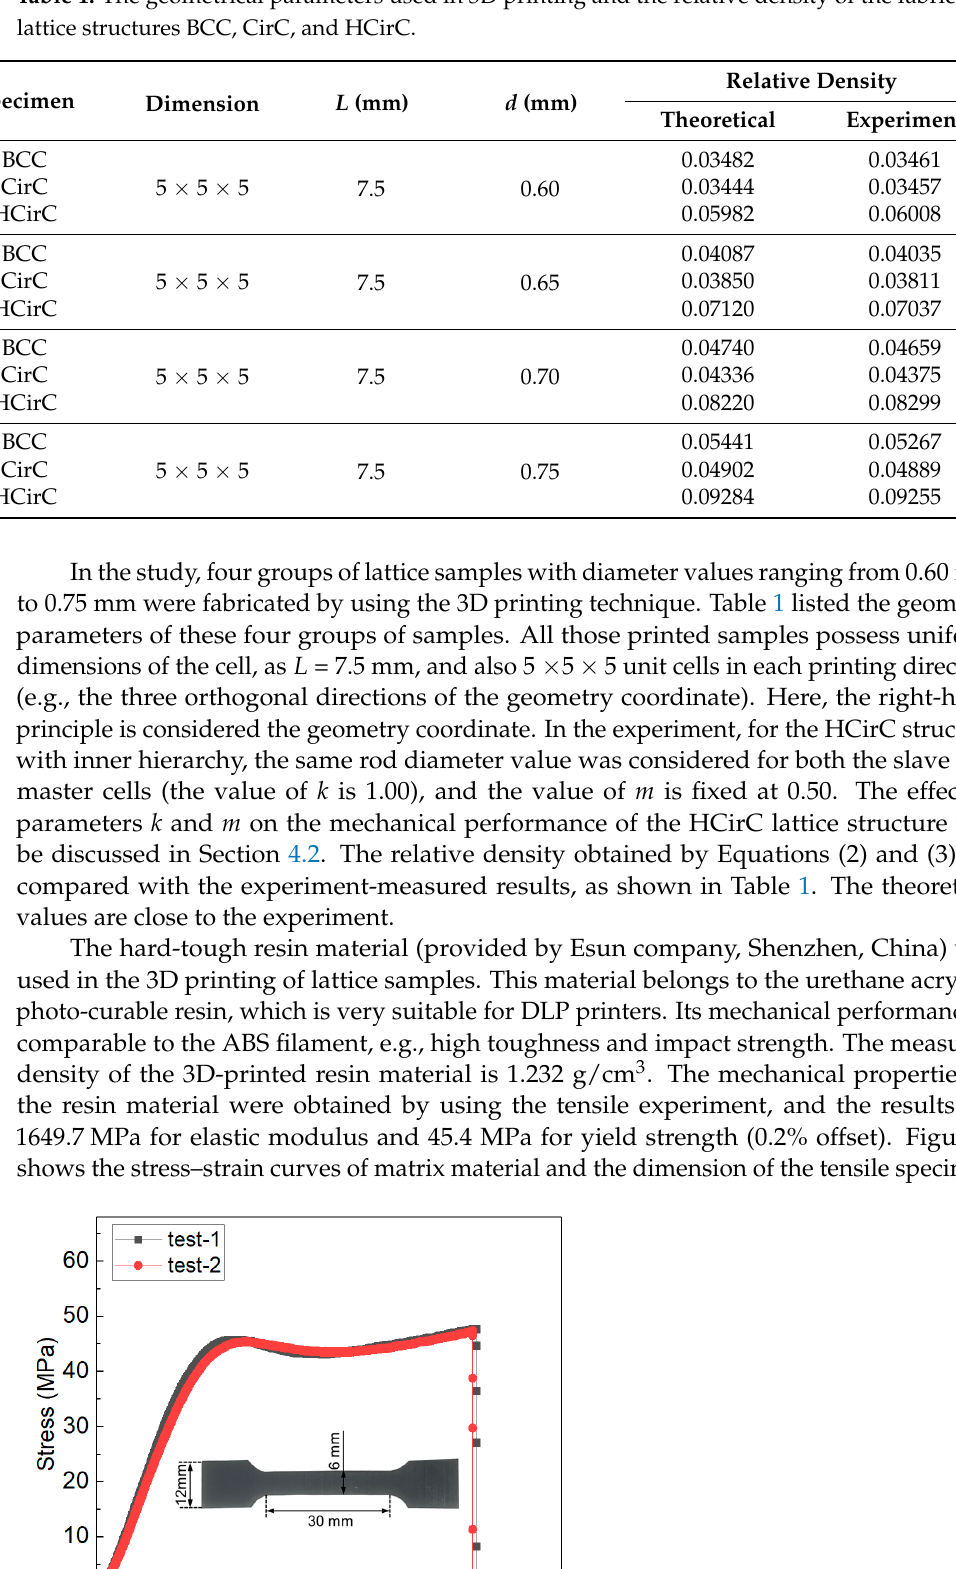
Table 1. The geometrical parameters used in 3D printing and the relative density of the fabricated lattice structures BCC, CirC, and HCirC.